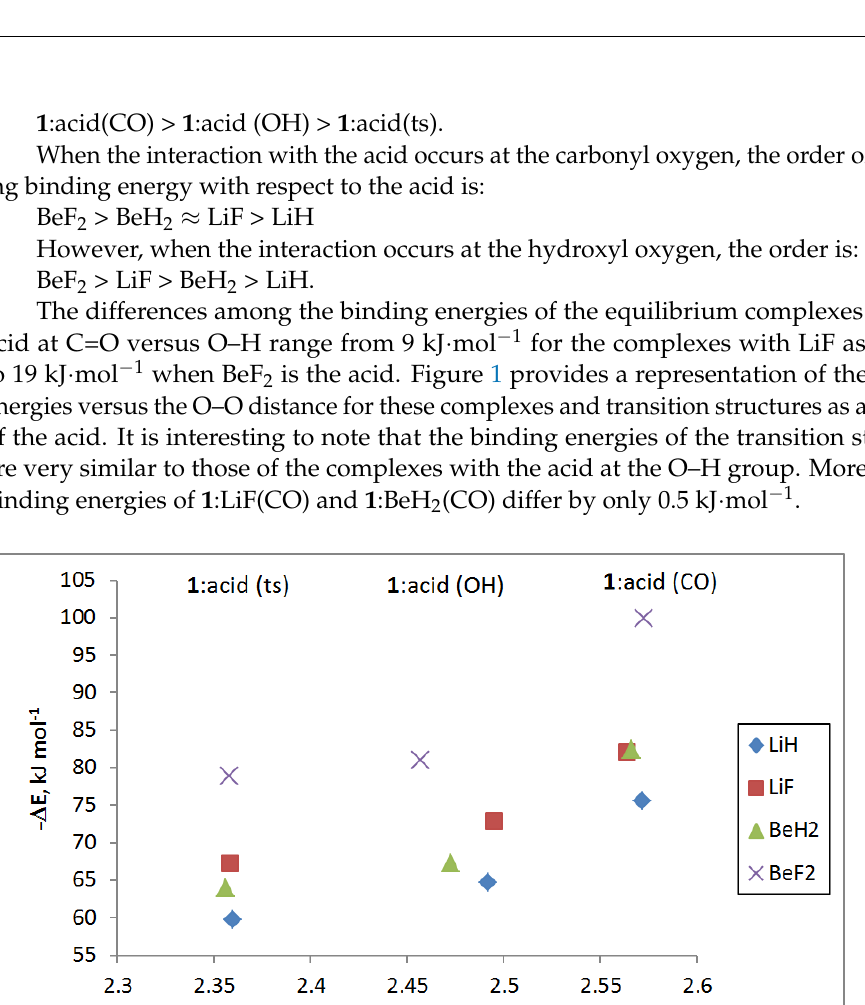
Table 1. Binding energies ( −Δ E, kJ . mol − 1 ), distances R (Å), and H–O–O angles (<, o ) for complexes of C 3 H 4 O 2 with acids.